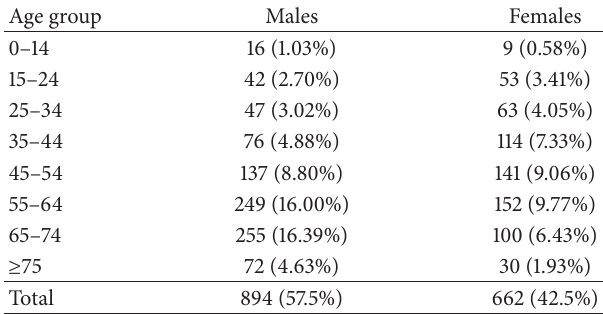
Table 1: Age-sex distribution of cancers ( 𝑛 = 1556 ) ∗